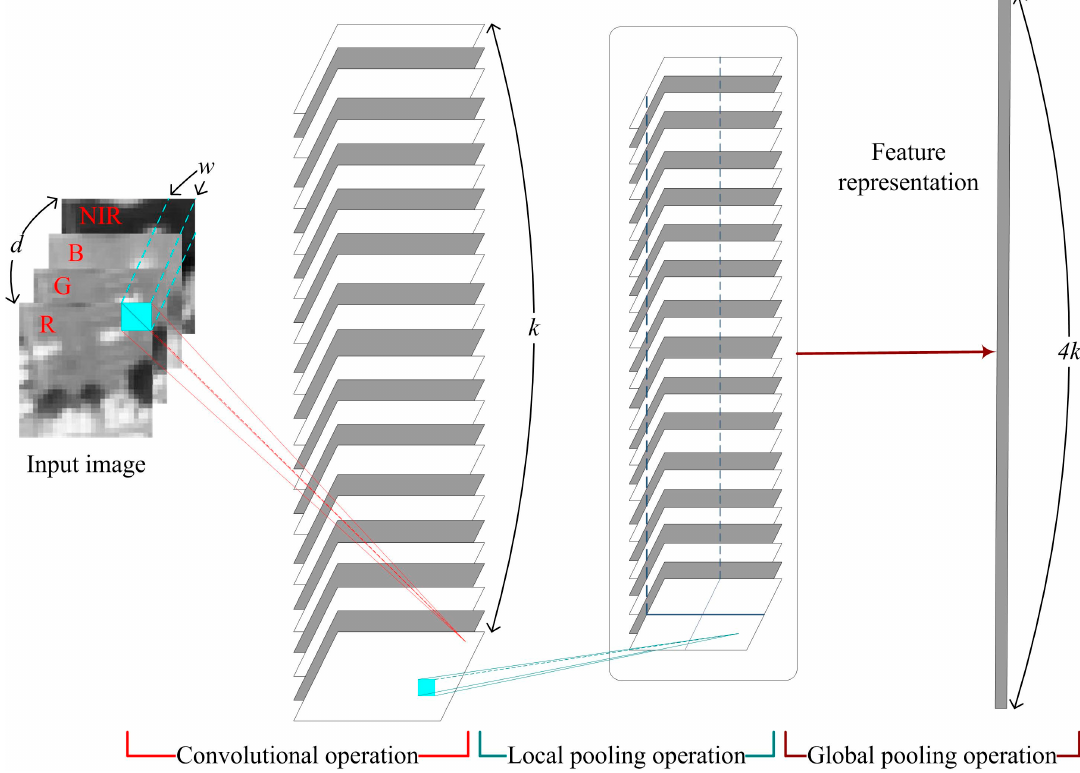
Figure 2. The unsupervised feature extraction network.